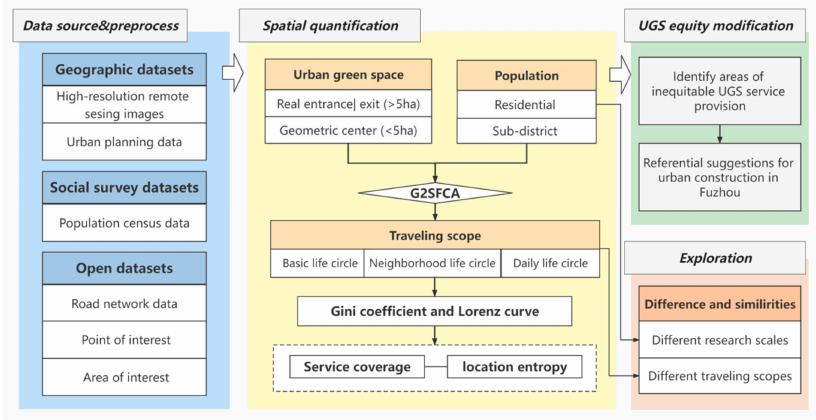
Figure 3. Technology